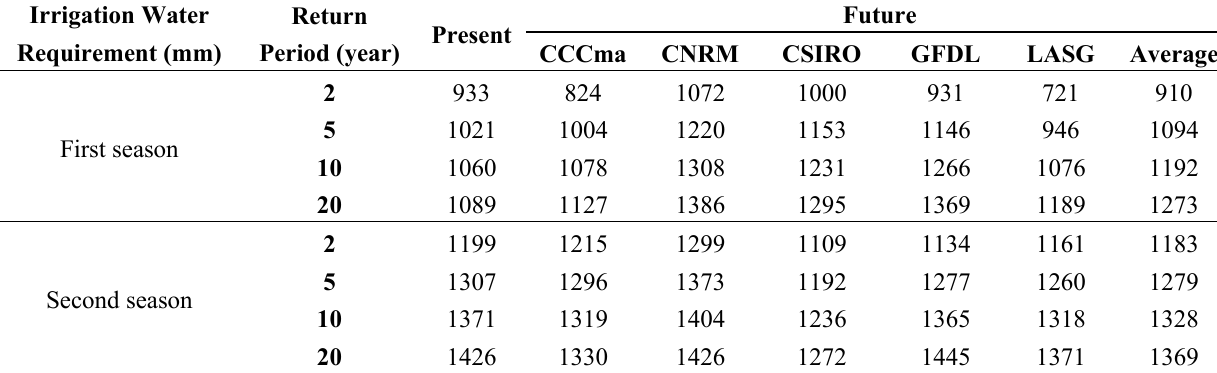
Table 4. Frequency analysis of irrigation water requirement in the present and